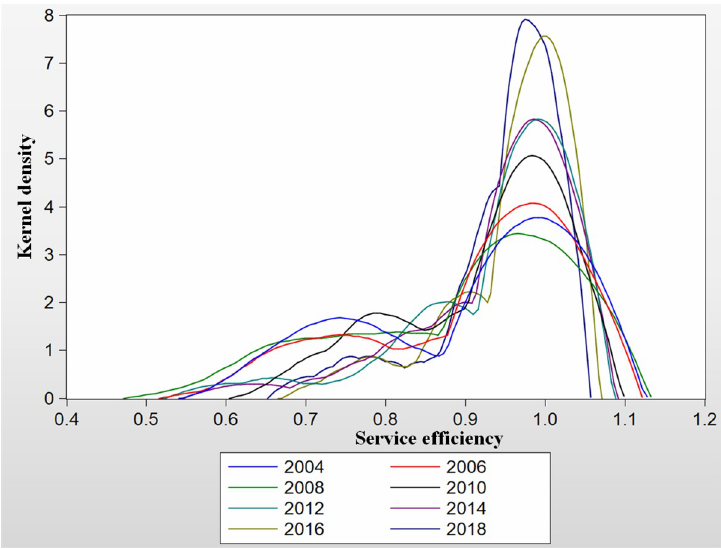
Fig 1. Kernel density distribution for China’s rural public health services efficiency from 2004 to 2018. In the curves, the change of the central position of the density function in the 8 years is not obvious. With an increase of the year, there is a tendency to gradually shift the kernel density distribution curve to the right. After 2010, the extent of the shift is slightly increased, indicating that the health service efficiency has a greater increase after 2010. In short, China’s regional health services have been slowly improving. From the view of the shapes of the curves, the 4 years on the left side of Fig 1 have smaller changes, but the years on the right side have the opposite trend. In 2004, 2006, 2008, and 2012, there are great differences in the curves of these 4 years, indicating a large gap in the development between regions. The shapes of the whole distribution curves show a steep first and then gentle trend, and also reveal a low concentration. From the view of the density value, the height of the main peak rises first and then declines, and the width of the main peak grad- ually becomes wider, which indicates that the polarization trend of the efficiency of the rural health services in China has been gradually weakening. During the observation period, the main peak value of the kernel density curve increases significantly, but the small peak value tends to decrease. This result means that the gap between the regions with low service efficiency in China is gradually increasing, but the gap between the regions with high services efficiency is decreasing. The interregional uncoordinated devel- opment is obvious. From 2004 to 2018, the center of the kernel density function did not change significantly. The highest peak value decreases year by year, and these peaks are wide. This result indicates that the distribution of the efficiency of health services is scat- tered. The wave of the kernel density curve shifts to the right, the vertical height of the peak decreases, and the horizontal width increases, which indicates that the index is increasing and the regional disparity becomes greater. This result means that from the view of the number of peaks, the kernel density distribution of China’s service efficiency has always shown the characteristics of a “scattered double peaks” model. The double peaks which were shown in all the curves indicate an uncoordinated development in Chi- na’s ecological efficiency. Furthermore, the polarization of the interregional coordination index has always existed.